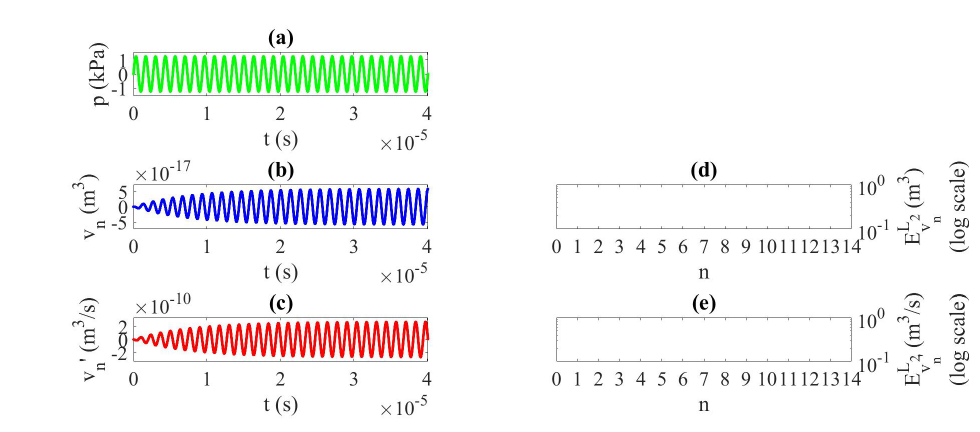
Figure 5. Case 1 (cid:48)(cid:48) . f = f b , high finite amplitude without nonlinear terms ( a = 0, b = 0). ( a ) Pressure source signal, ( b ) bubble-volume variation, ( c ) speed of bubble-volume variation; last iteration n = N . L 2 -norm error at each iteration n of the calculation; ( d ) v n , ( e ) v (cid:48) n .